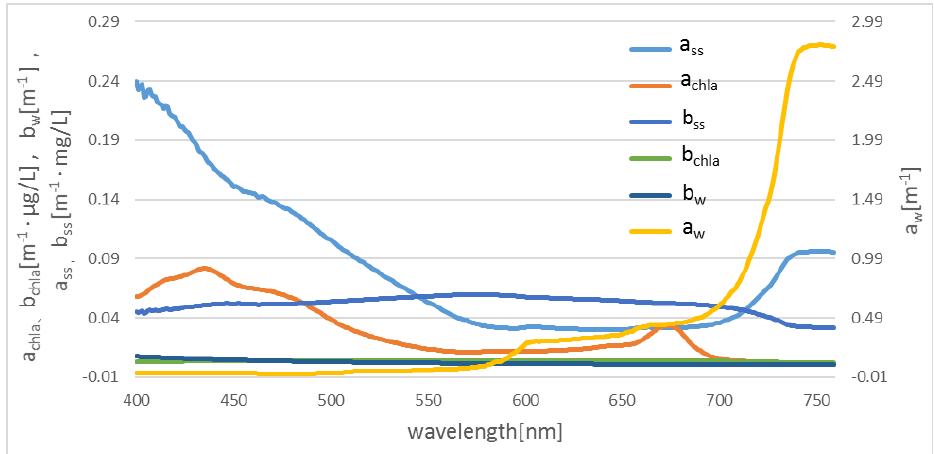
Figure 5. Inherent optical properties (IOPs) of SS, Chl, and pure water.